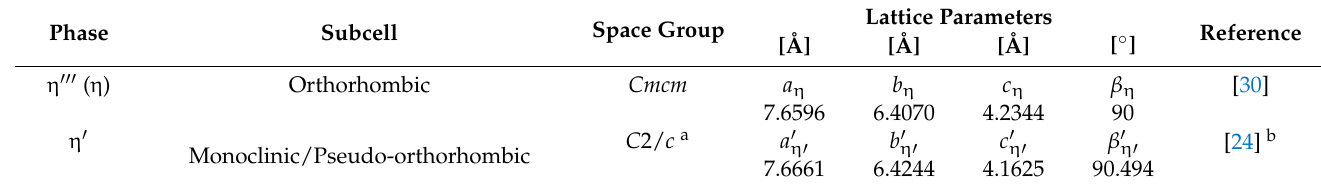
Table 2. Lattice parameters of the phases contained in the Al 72.8 Fe 27.2 alloy powder investigated in the present work by EBSD analysis, as determined by Rietveld refinement from powder-XRD data of the same powder [24,30]. The unit cells chosen correspond to the orthorhombic cell of the parent disordered structure for simplicity (see also Figure 1). Atomic positions are given in Appendix A in Table A1. The respective primes for the lattice parameters emphasize that they refer to a subcell. Lattice Phase Subcell Space Group